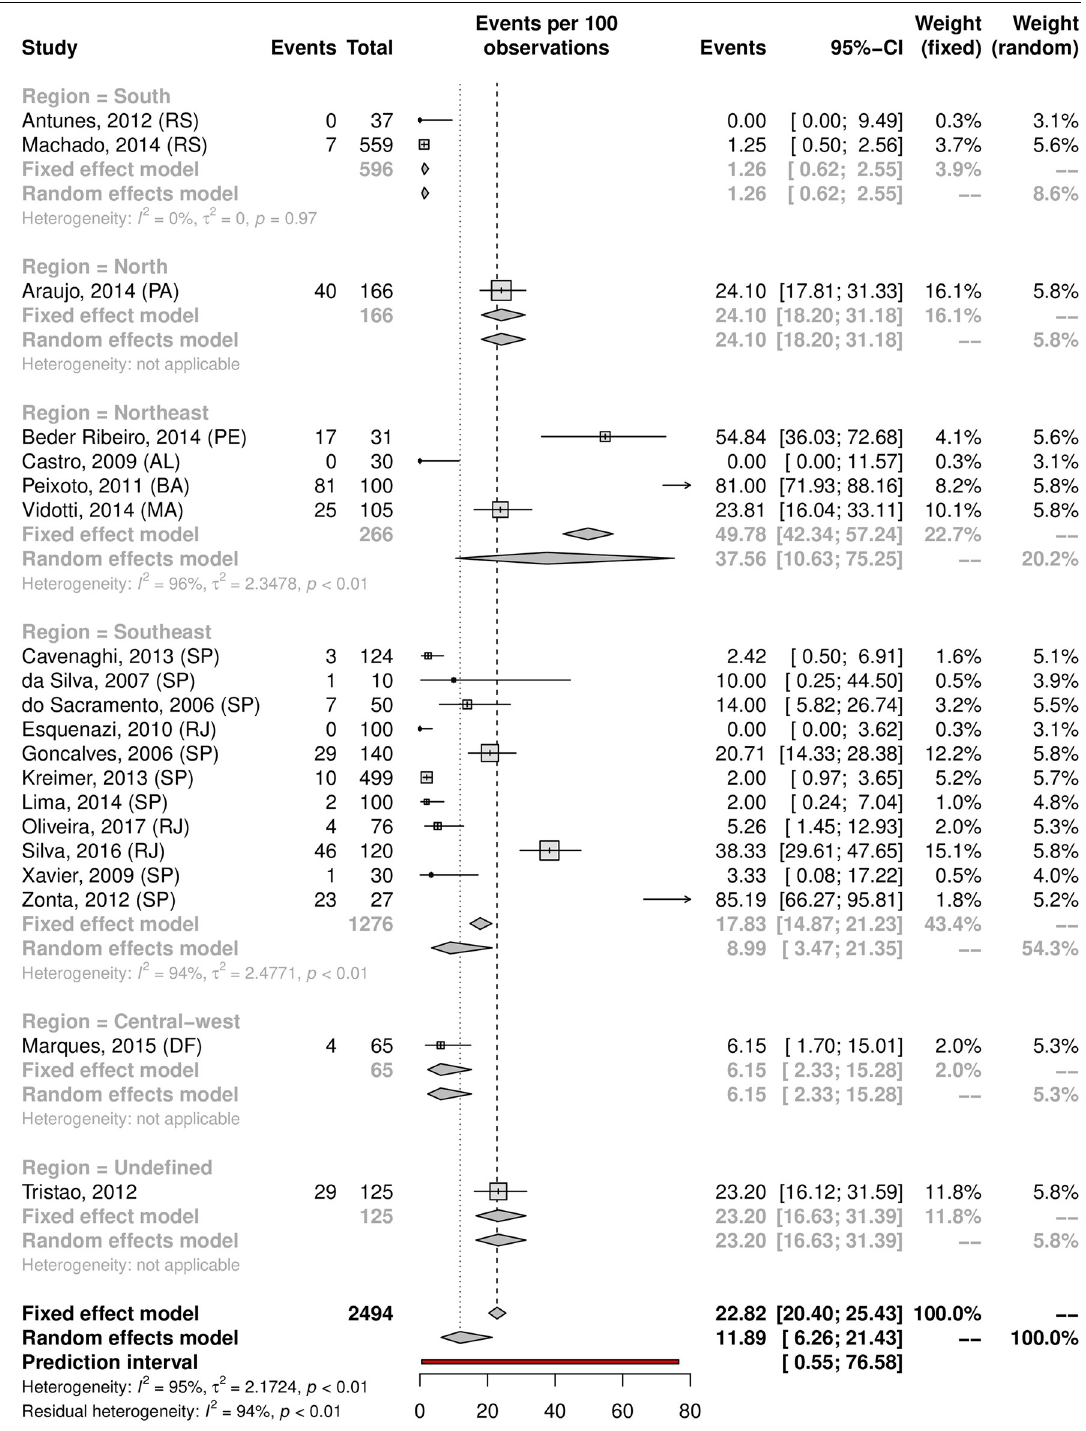
Fig 25. Prevalence of oral HPV infection in Brazil, by region. Forest plot of a metanalysis of studies reporting prevalence of oral infection by HPV, stratified by region in which each of them took place.